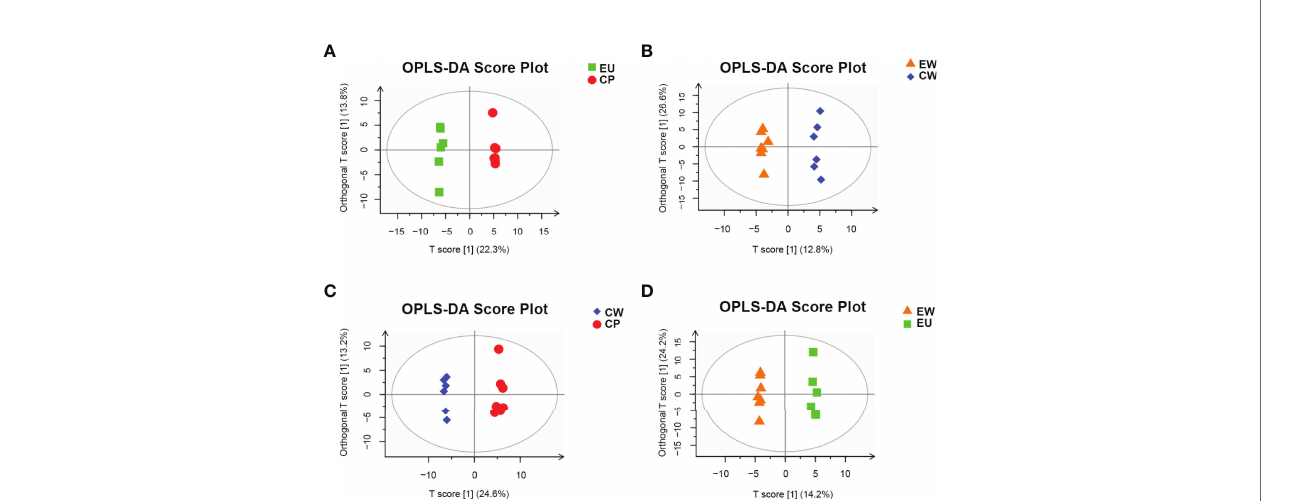
FIGURE 3 | OPLS-DA score plots for pairwise comparisons between UV-WSSV trained immunity and control groups. (A) EU vs. CP, (B) EW vs. CW, (C) CW vs. CP, and (D) EW vs. EU